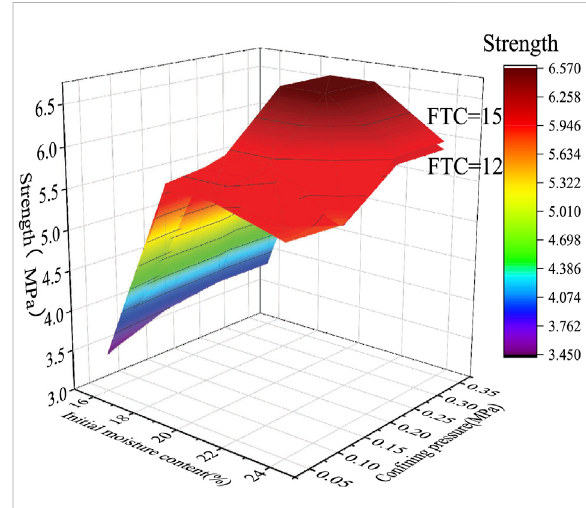
FIGURE 16 Prediction of unknown working conditions by PSO-LSTM